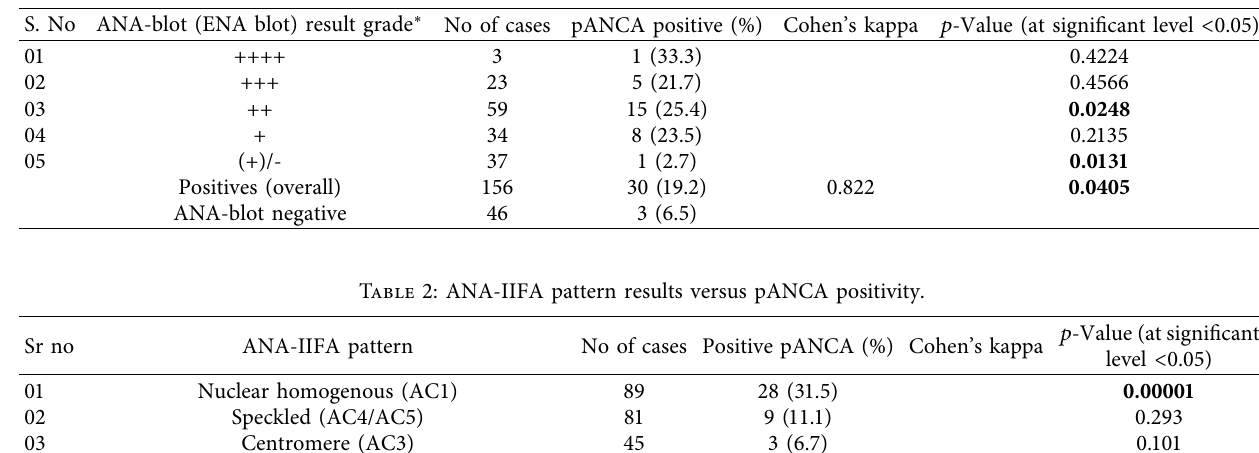
Figure 1: Flow diagram of the Table 1: ANA blot (ENA) results (with grading) versus pANCA positivity.